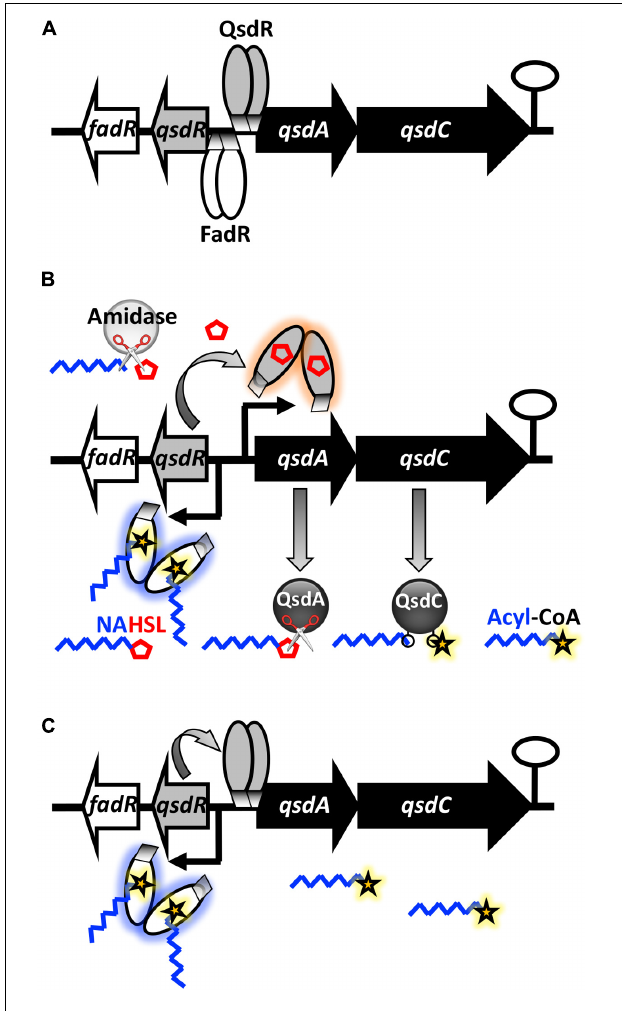
FIGURE 8 | Proposed model for the regulation of the qsd operon expression by quorum-sensing signals in R. erythropolis . (A) In the absence of an inducer, the TetR-like QsdR regulator forms a dimer that binds to the promoter region and directly represses qsdA and qsdC expression, switching off the pathway. (B) When N- acyl- L -homoserine lactones (AHLs) are present in cellular environment, some of them are cleaved by the previously characterized extra-operonic gene encoded AHL amidase (Latour et al., 2013) which hydrolyses the amide bond of these molecules (symbolized by scissors). The γ -butyrolactone ring moiety (i.e., homoserine lactone) binds to QsdR, thereby changing the conformation, such that QsdR cannot bind to the promoter region, inducing derepression of the qsd cluster gene expression. This leads to the production of QsdA and QsdC enzymes, responsible for the lactone ester bond hydrolysis and activation (coenzyme A ligation) of the aliphatic part of signaling molecules, respectively. (C) When AHL molecules are fully hydrolyzed, the disappearance of HSL rings restores the binding between QsdR and the DNA promoter sequence leading to the lock of qsd operon expression by the QsdR repressor. The concomitant increasing in the intracellular amount of acyls-CoA molecules facilitates this phenomenon, since these molecules bind to the effector domain of the FadR regulator, causing a conformational change in the dimeric protein and the production of the QsdR repressor. This step is proposed according to in silico analysis of the genome of R. erythropolis strain R138 and the recent and well-documented bibliography related to the functioning of FadR regulator (Bacik et al., 2015; My et al., 2015). (Black curved arrows and hairpin represents the initiation of gene transcription and a putative transcription terminator,